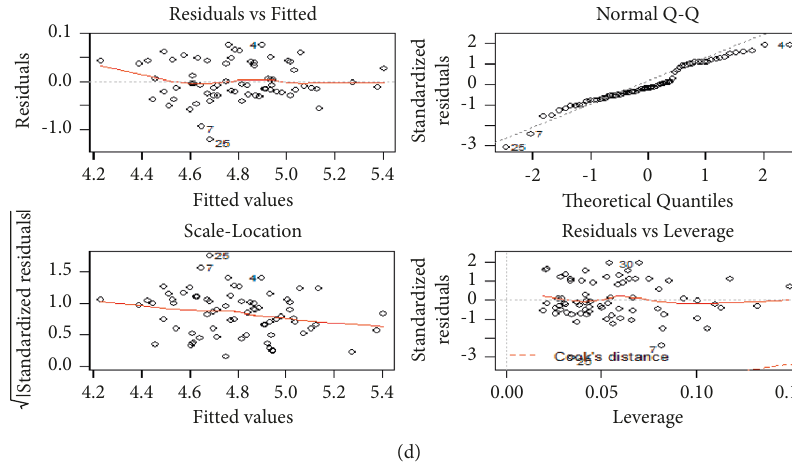
Figure 10: Residual plots for the regression equations given in Table 2. (a) Full sample equation. (b) Low-income equation. (c) Middle- income equation. (d) High-income